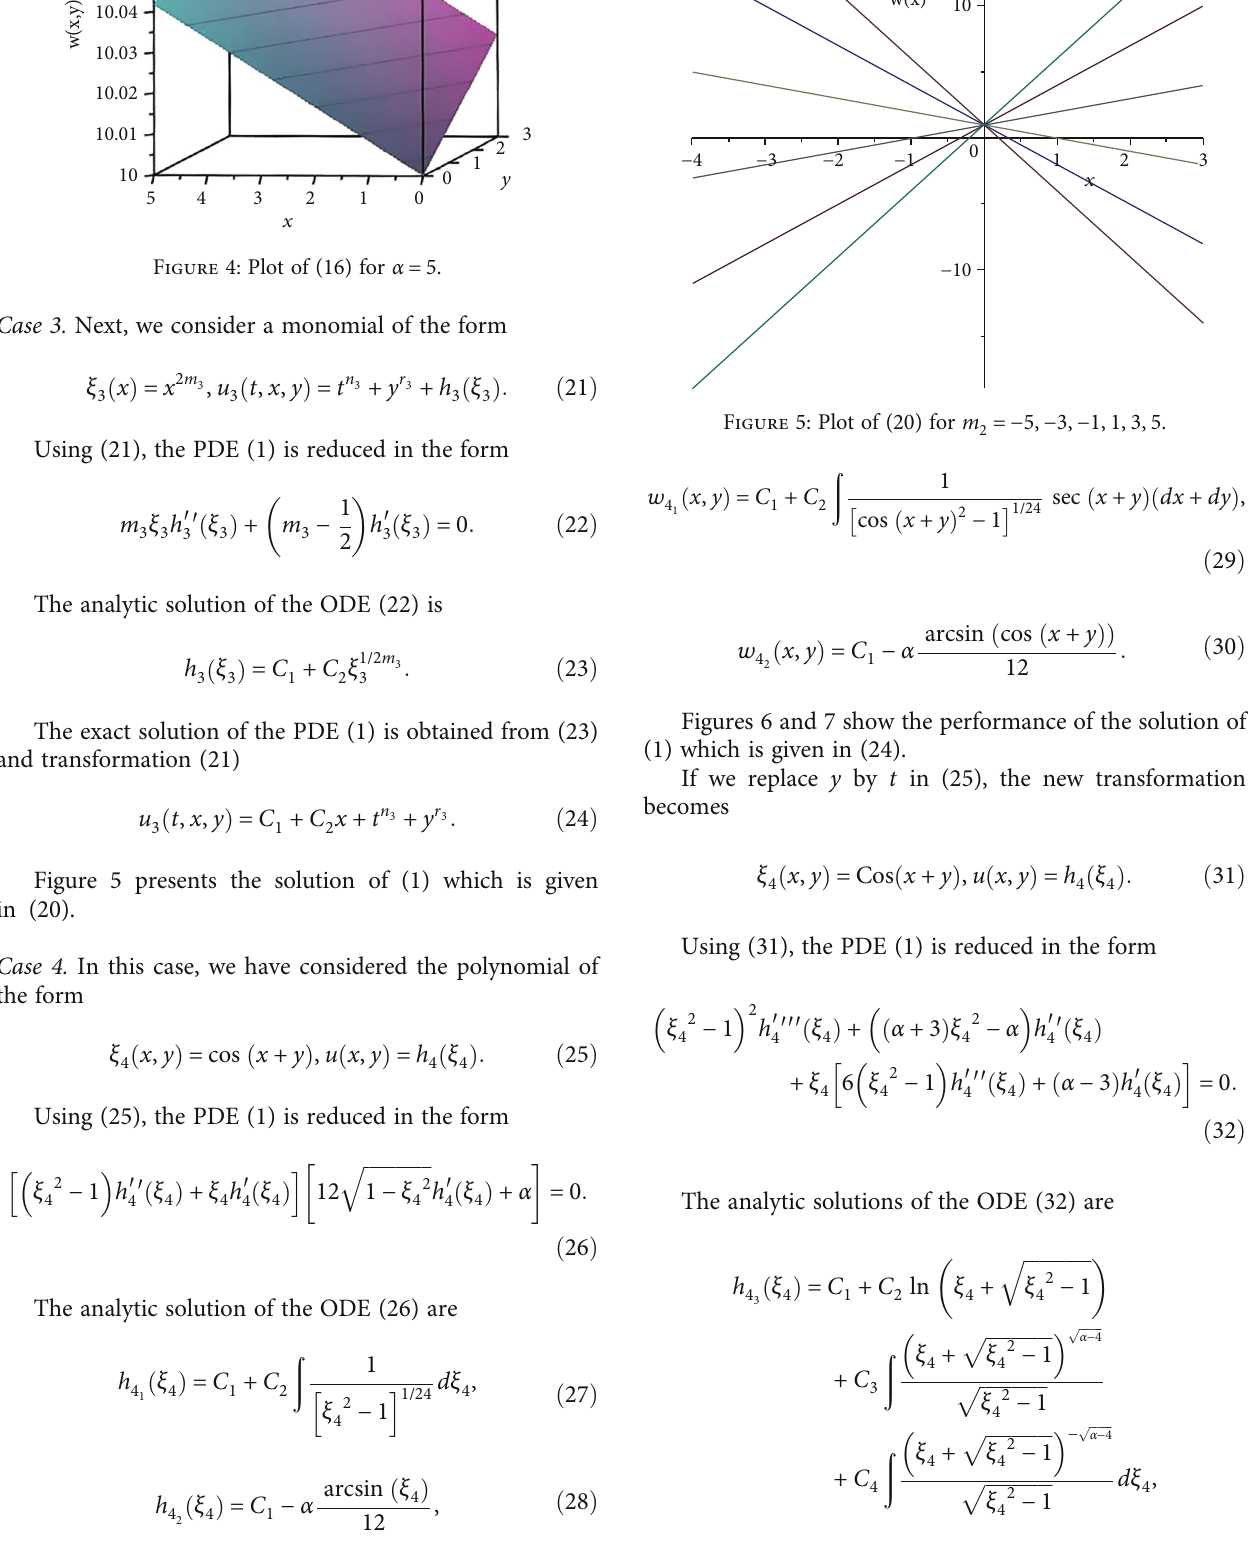
ffiffiffiffiffiffiffiffiffiffiffiffiffi p ξ 42 − ffiffiffiffiffiffiffiffiffiffiffiffiffi ξ 42 −